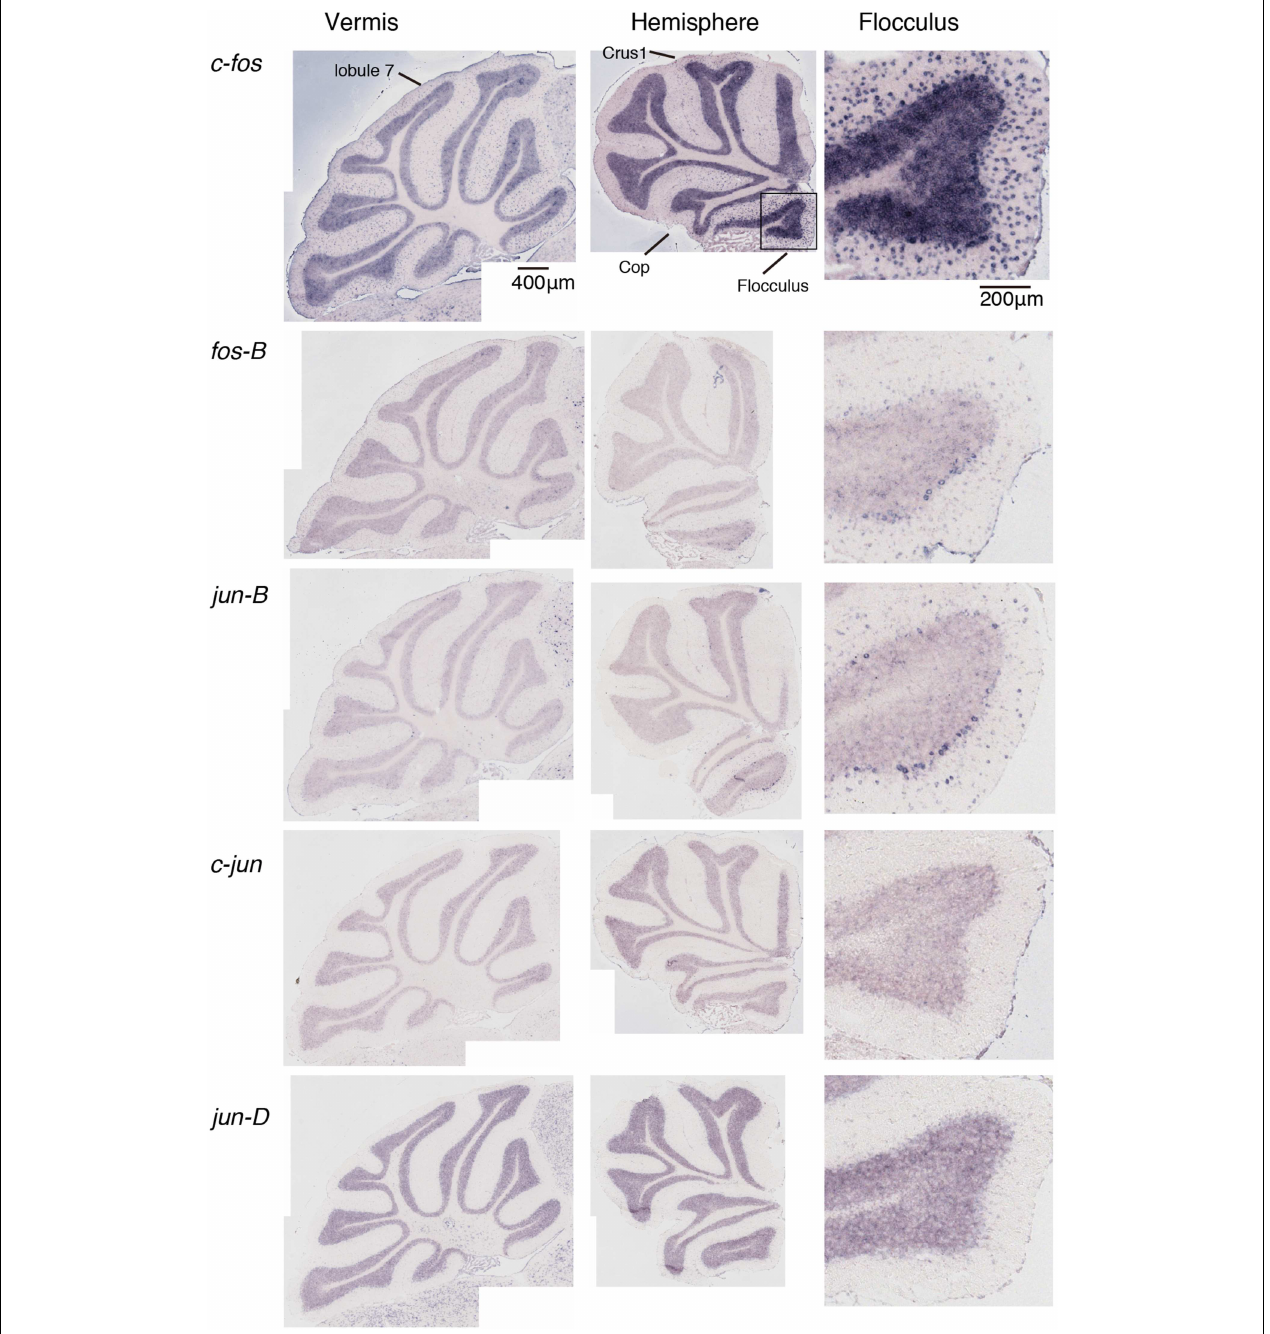
FIGURE 4 | Expression patterns of eight IEGs in the cerebellum of mice that performed rota-rod tasks. IEG expression patterns in the mice that performed three trials of the rota-rod tasks (see Materials and Methods). The figures are lined up in the same order as in Figure 1